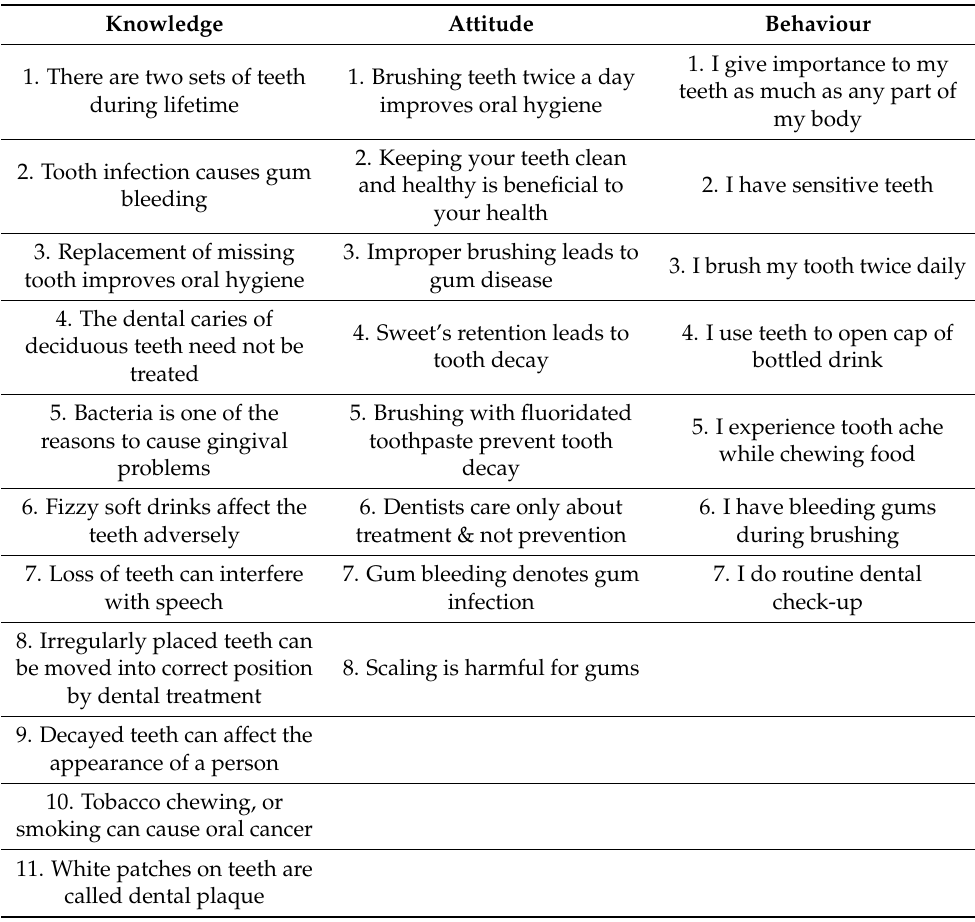
Table 1. Oral health KAB Questionnaire.